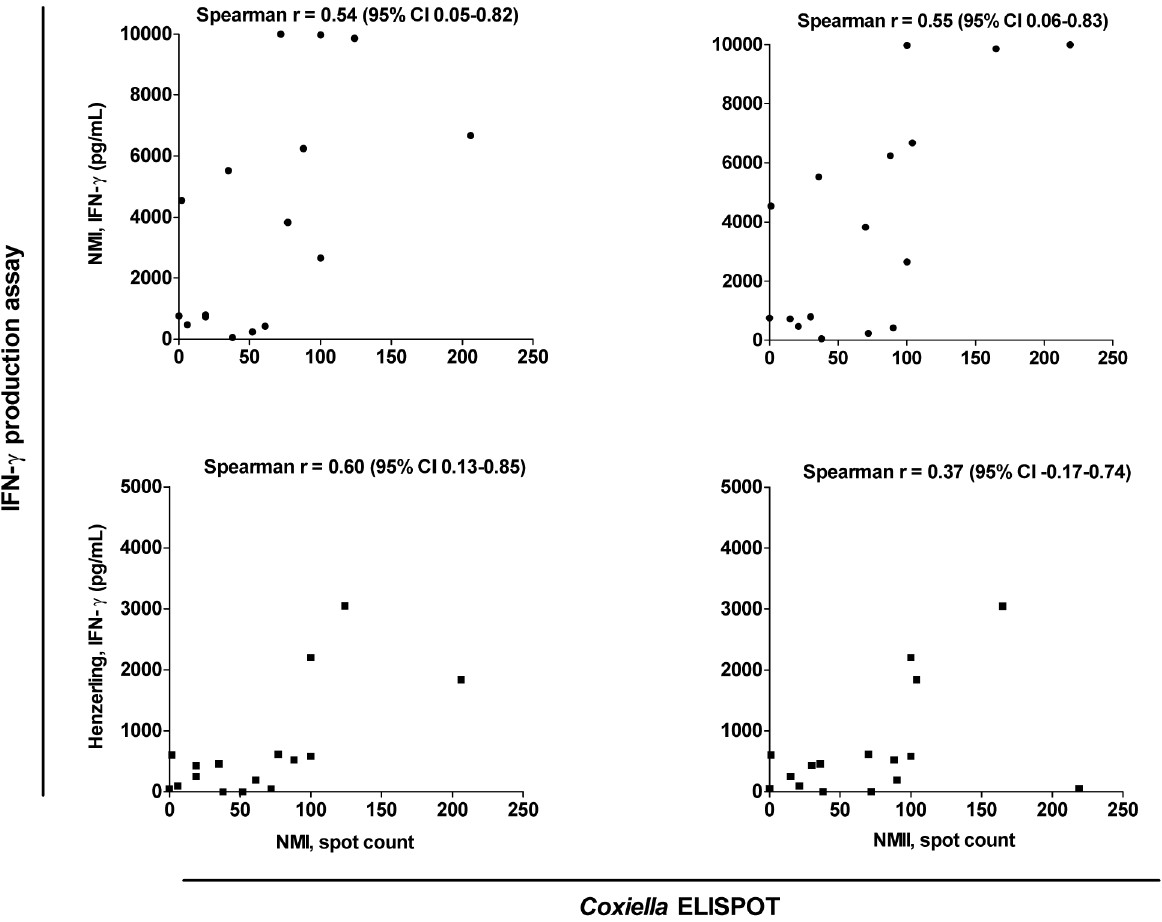
Figure 3. Correlation between the amount of C.burnetii -specific IFN- c production and the number of IFN- c positive cells. The individual values of chronic Q fever patients (n=16) were used to determine the correlation between the IFN- c production as measured with the IFN- c production assay, and the number of IFN- c positive cells as measured with the Coxiella ELISPOT. Each graph shows the correlation between the resulting values of the two assays, with either one of the stimulating antigens. On the Y-axes, the IFN- c production is shown after stimulation with NMI (upper graphs) and Henzerling antigens (lower graphs). On the X-axes, the spot count is shown after stimulation with NMI (left graphs) and NMII (right graphs) antigens. The Spearman’s correlation coefficient r (95% Confidence Interval) is given for each comparison. Abbreviations: NMI, Nine Mile phase 1; NMII, Nine Mile phase 2; IFN- c , interferon-gamma.